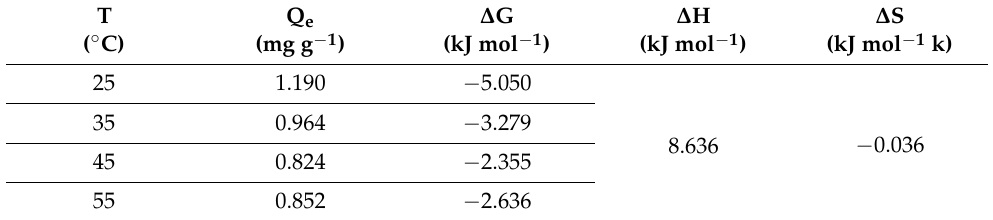
Table 2. The calculated values of thermodynamic parameters of the adsorption of CVD onto S. costatum